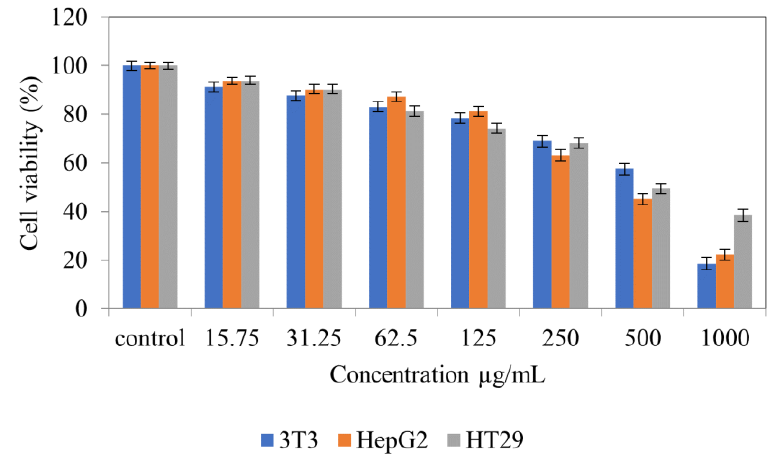
Figure 7. Cytotoxic activity of ethyl acetate extracts against cell lines at 48 h.